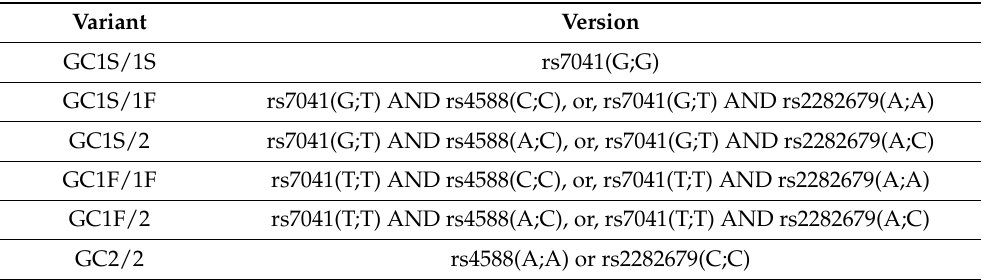
Table 1. Characteristics of vitamin D binding protein polymorphisms in most common variants (based on Rozmus et al. 2020 with modifications [18,21]).